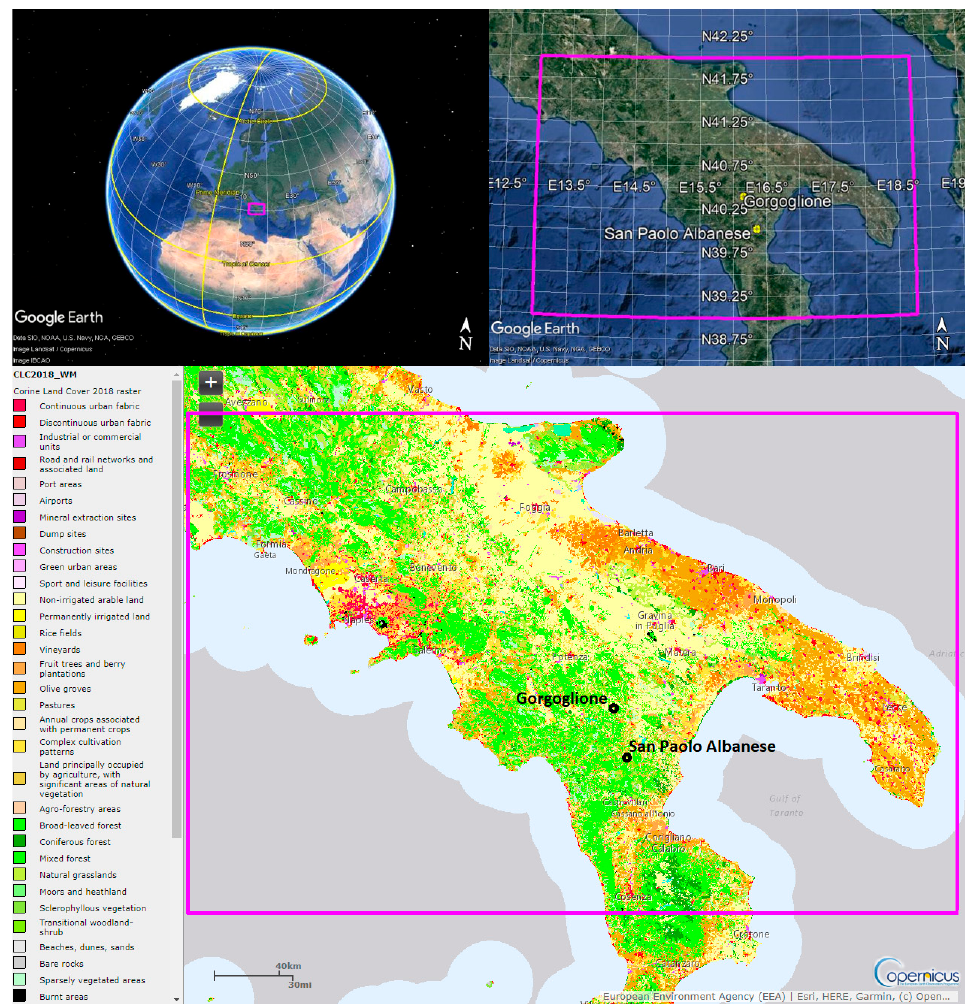
Figure 1. Target region for which IASI data have been selected for the present analysis. The figure also shows the CORINE land cover for 2018 to help identify forest regions, which are primarily of interest for this study. The two upper panels help to determine the target area (magenta square) on the globe and Italy.